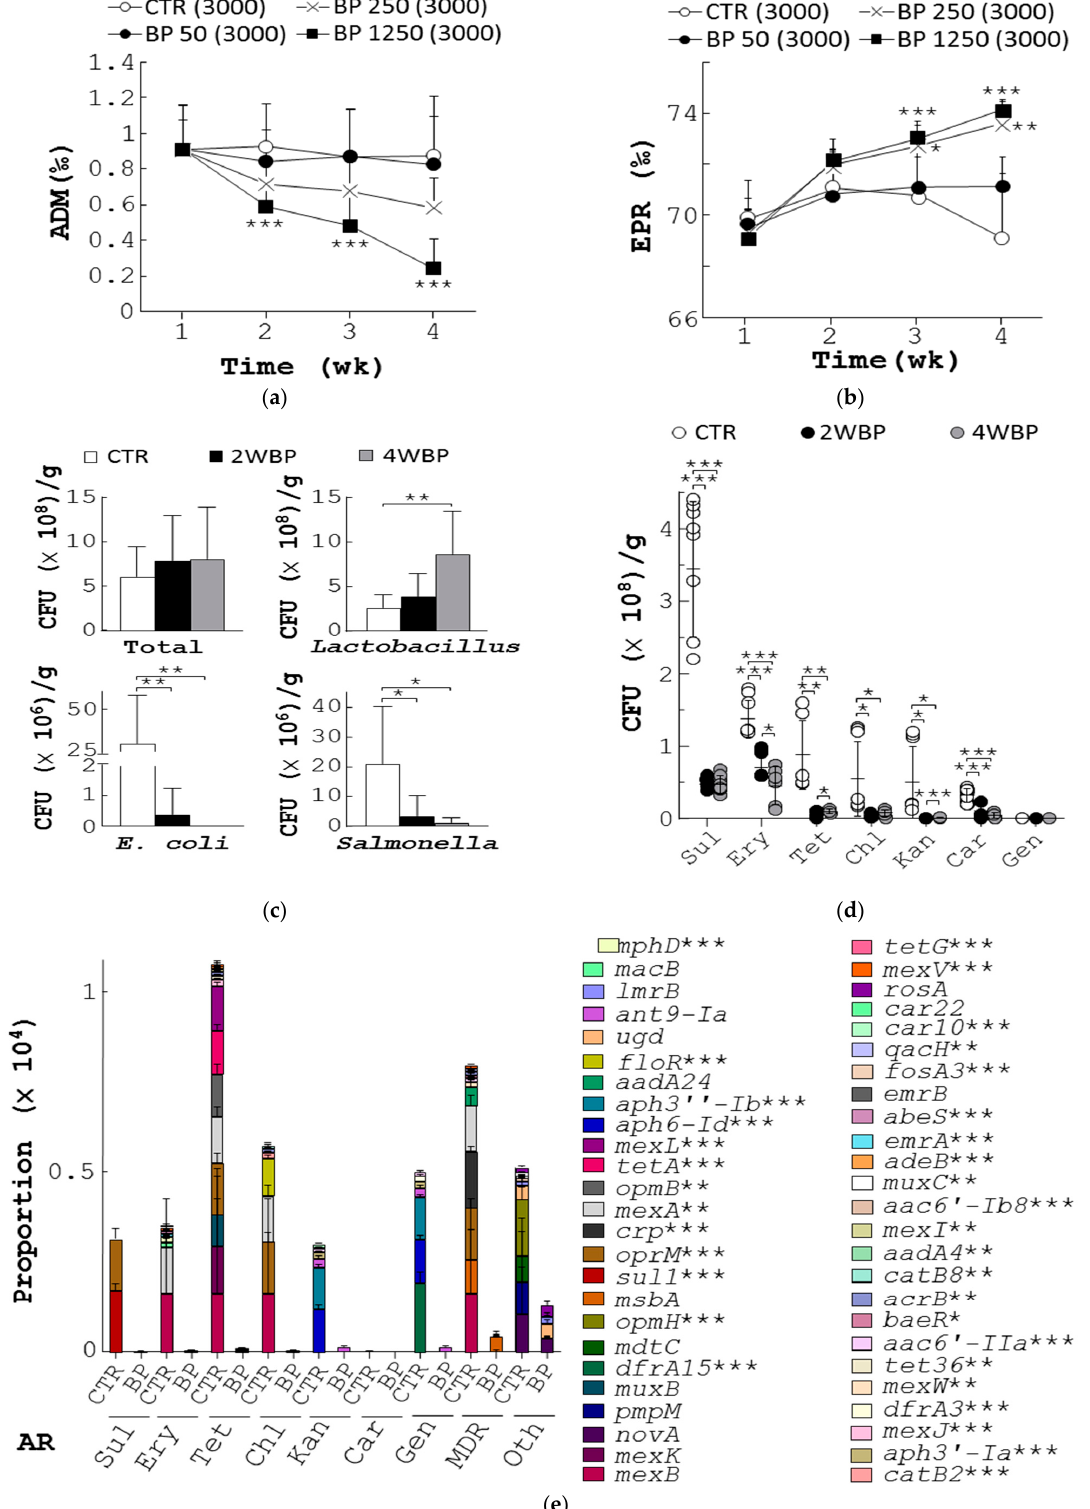
Figure 1. Beneficial effects of BP on animal health, egg production, and gut microbiota in aged laying hens. ( a , b ) Four groups of 54-week-old laying hens, 3000 birds a group, were fed with standard diet (CTR) or the diet containing BP at 50 ppm (BP 50), 250 ppm (BP 250), and 1250 ppm (BP 1250) for 4 weeks. Their ADM ( a ) and EPR ( b ) were determined. ( c ) Sixteen stool samples ( a ) from control hens (CTR), aged 58 weeks, and the hens fed with 250 ppm BP for 2 weeks (2 WBP) and 4 weeks (4